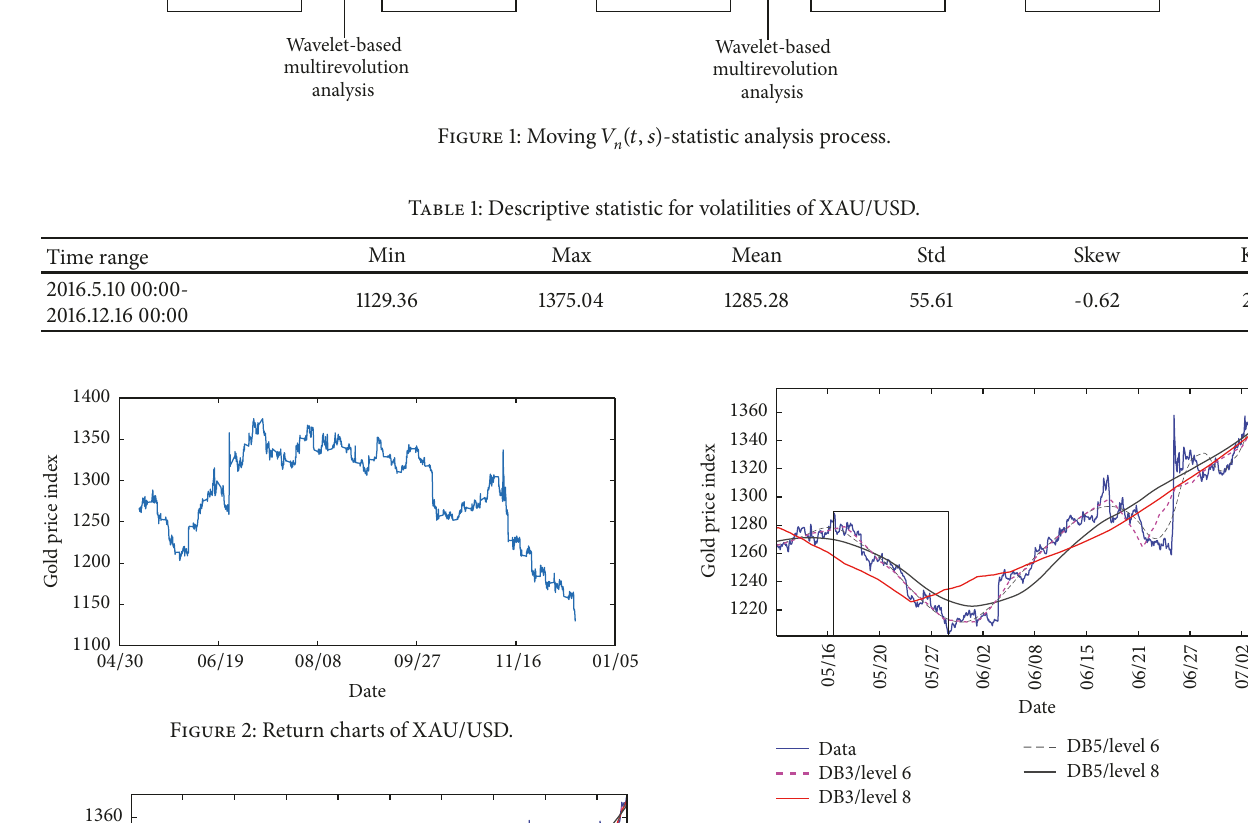
Figure 4: DB3 and DB5 wavelet analysis on Level